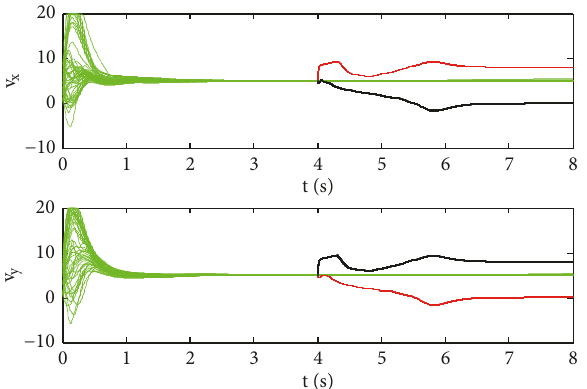
Figure6:Velocityofindividualsunderthecontrolalgorithmof[19].